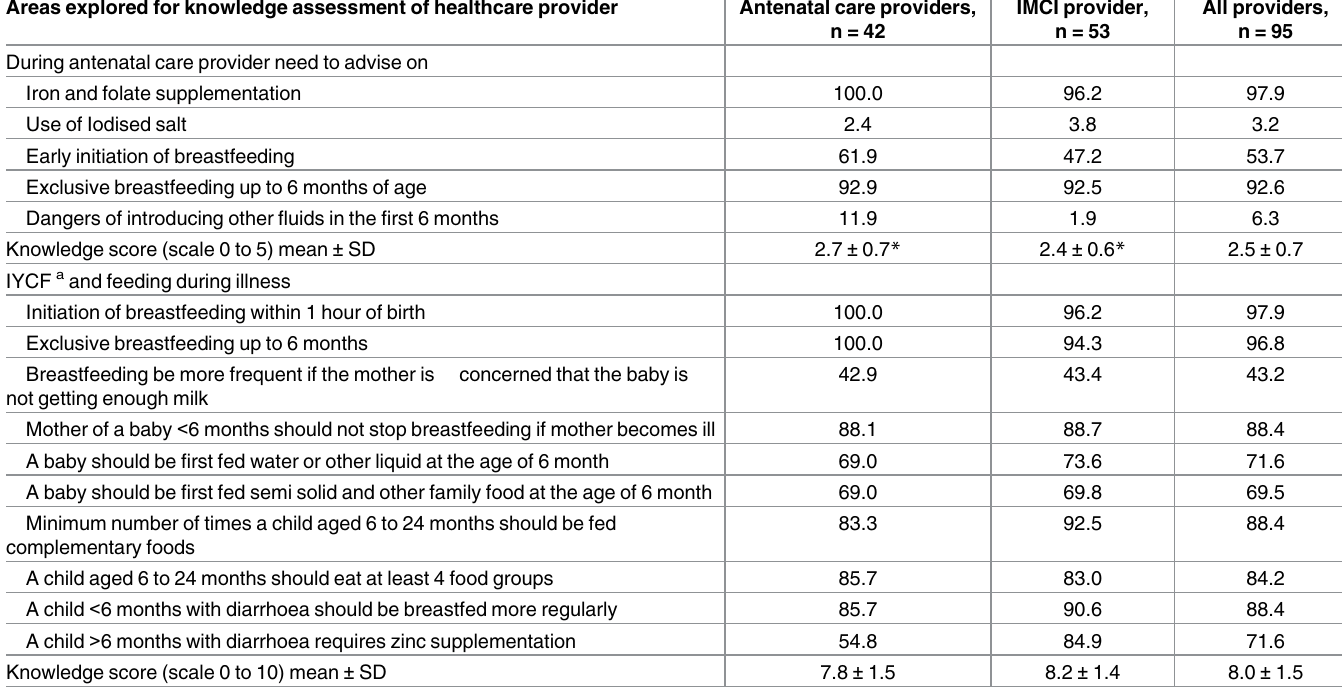
Table 4. Healthcareprovider’s knowledge of antenatal care nutrition and infant and young child feeding practices. Areas explored for knowledge assessment of healthcare